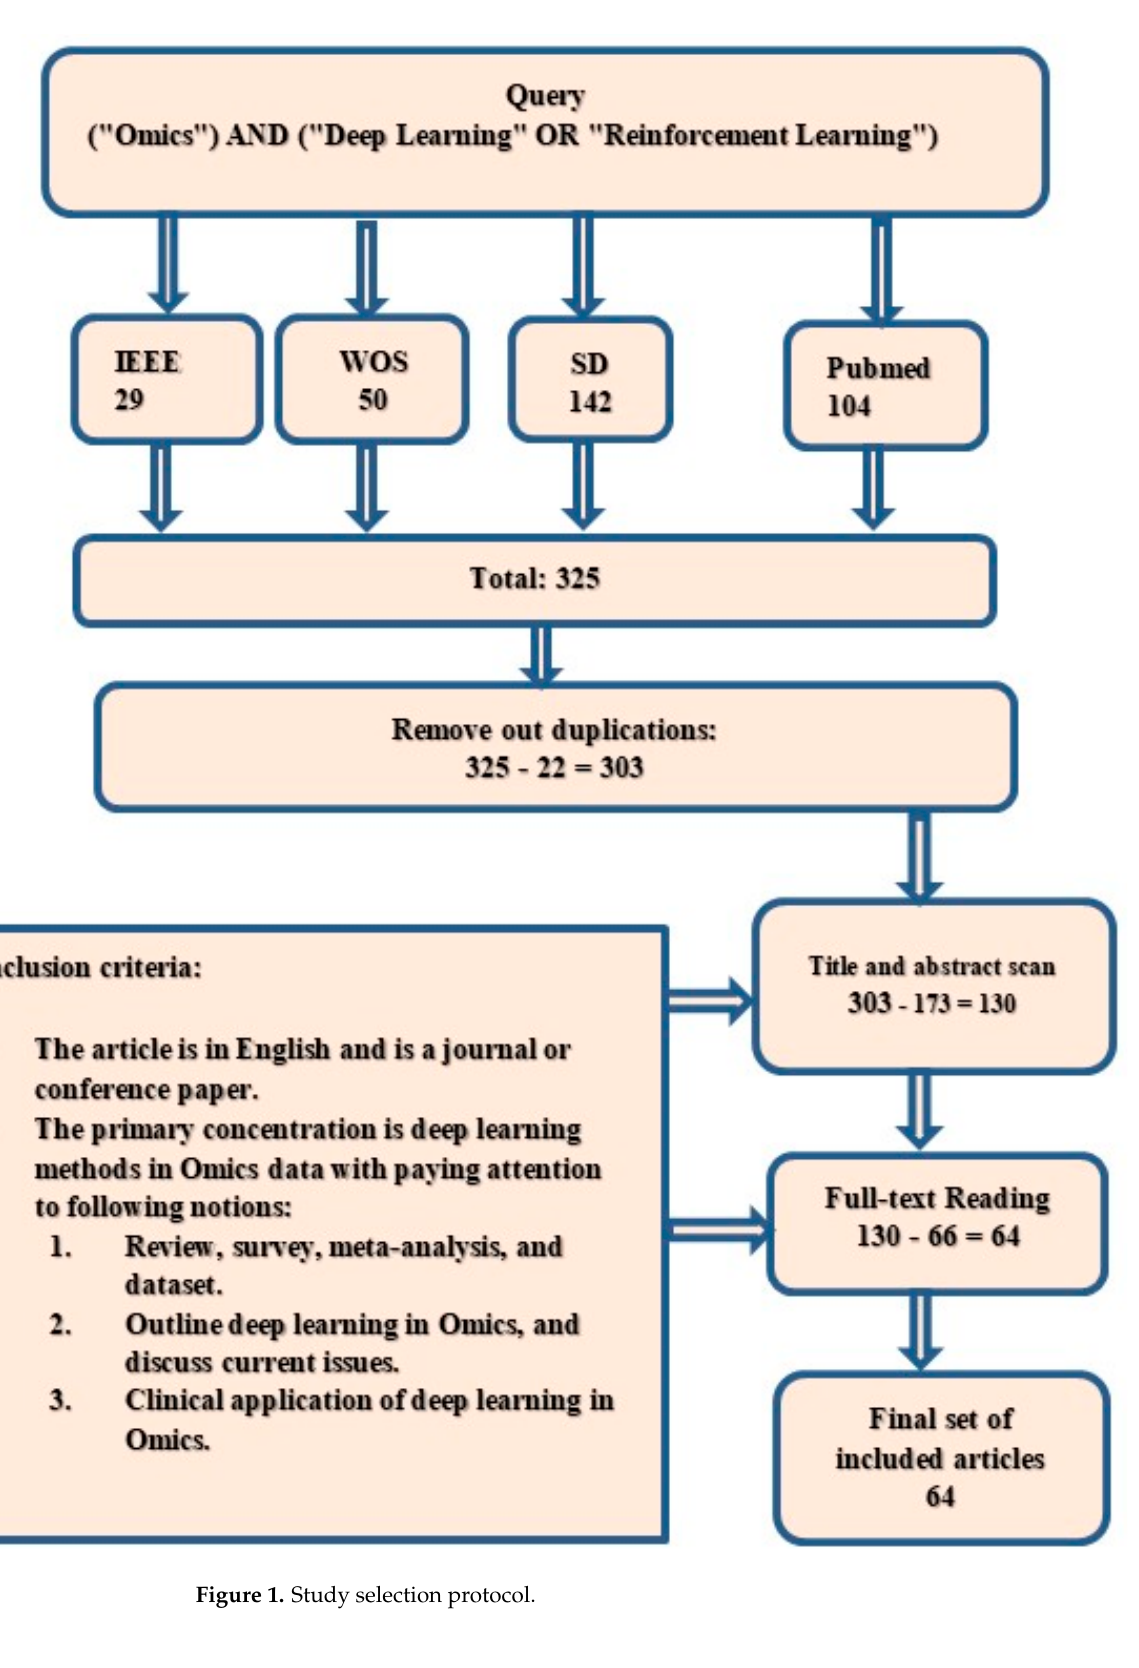
Figure 1. Study selection protocol.